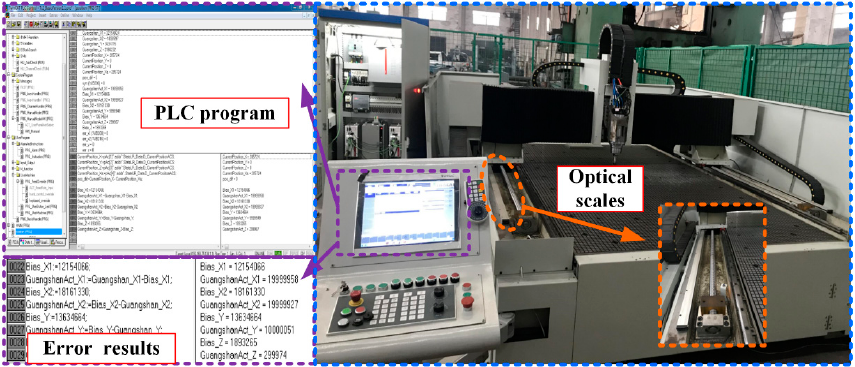
compensation with the tool center moving along the X -direction.